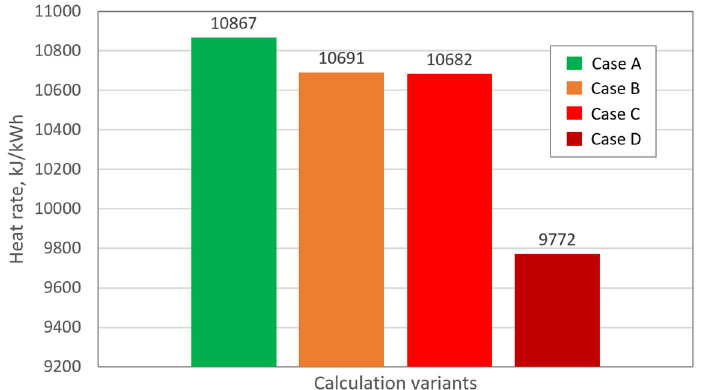
Figure 11. Heat rate for different parameters of steam feeding the turbine.